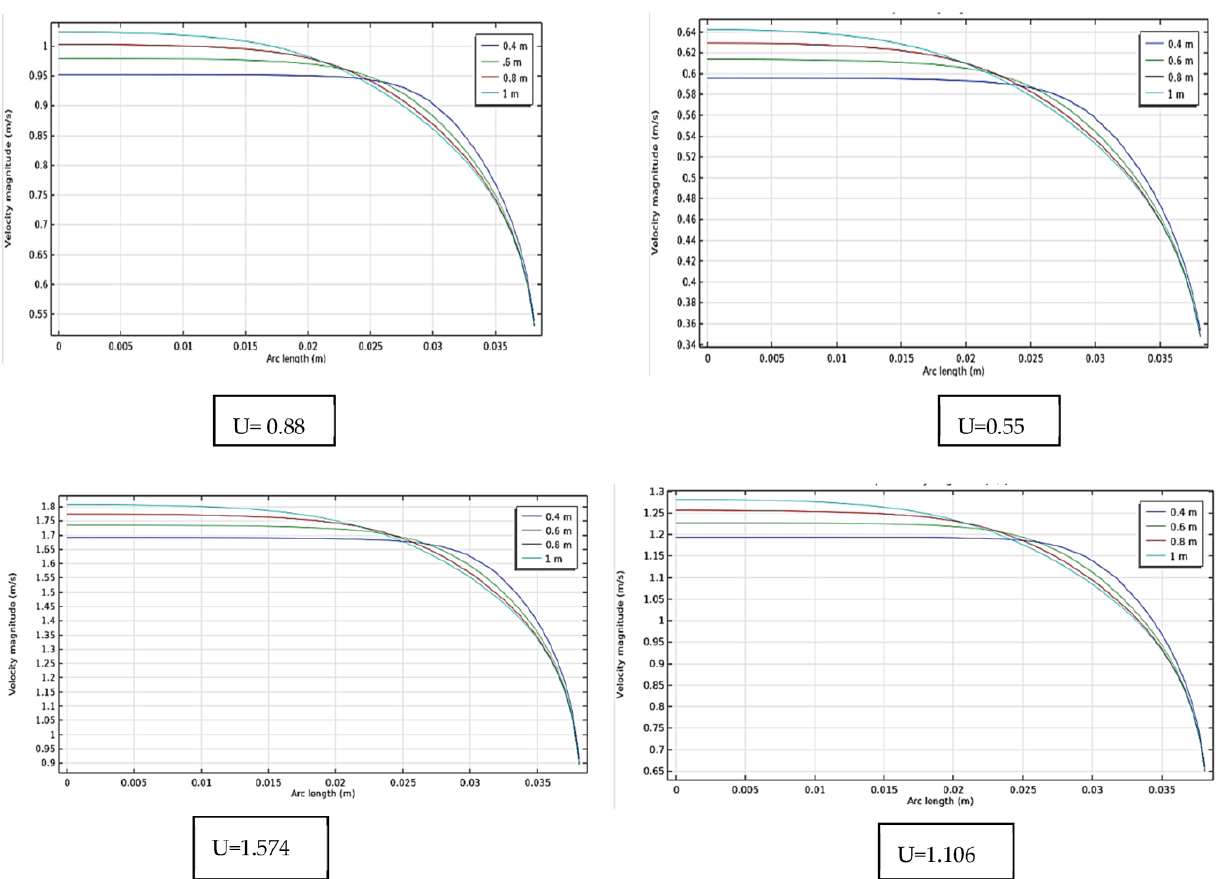
Figure 7. Velocity variation along the 1-m-long pipeline without XGs.